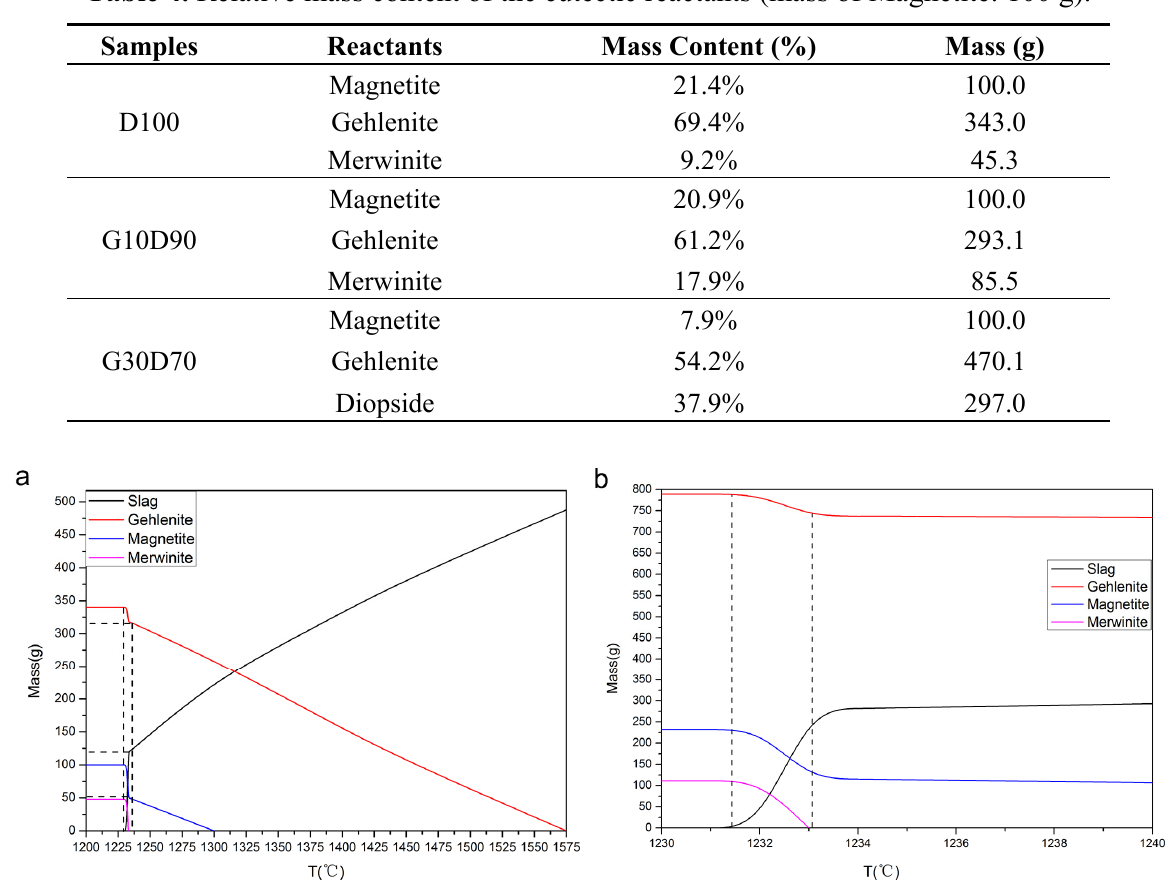
Figure 6. Mass of gehlenite, merwinite, magnetite, and slag at each thermodynamic equilibrium state (D100): ( a ) 1200 °C to 1575 °C; ( b ) 1230 °C to 1240